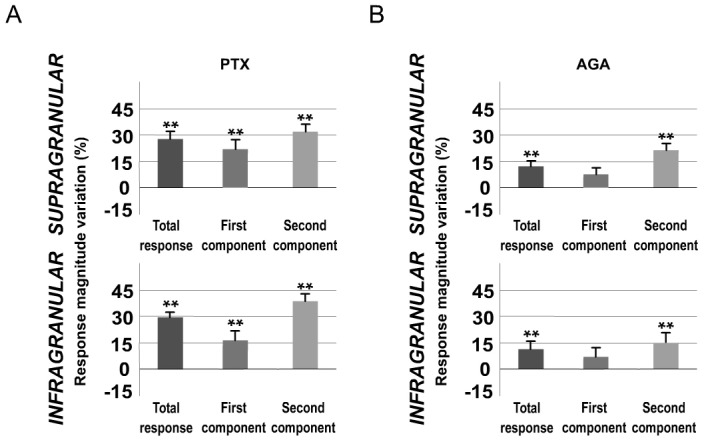
Blocking GABAergic inhibitory transmission in L1 enhances whisker responses.Change (%) in mean sensory response magnitude by PTX (A) or AGA (B) application in L1. Blocking GABAergic inhibitory transmission in L1 by PTX increased significantly whisker response magnitude in infra- (bottom row) and supragranular layers (top row) more strongly in the second component of the response. AGA application enhanced sensory responses in infra- and supragranular neurons. However, in both layers, AGA did not induce significant effects in the first component. * P<0.005; ** P<0.001.